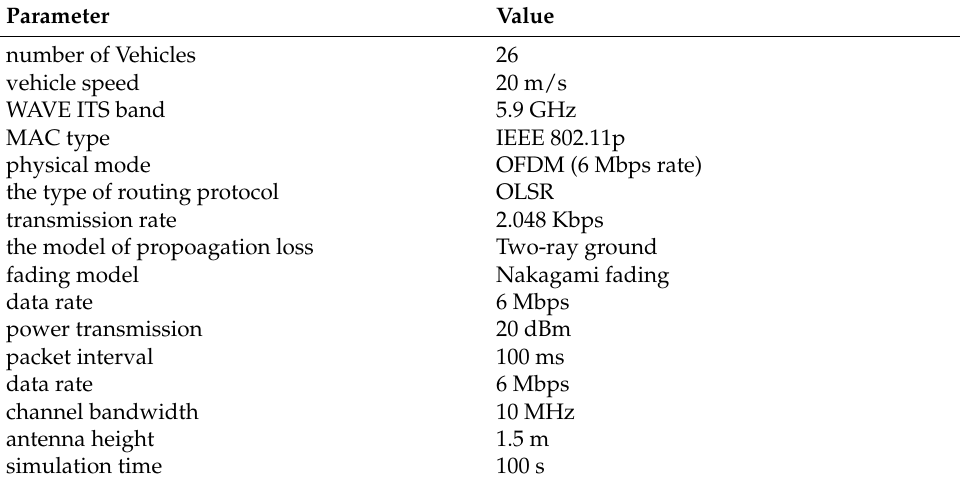
Figure 6. Simulation scenario map. Table 2. Simulation parameters of